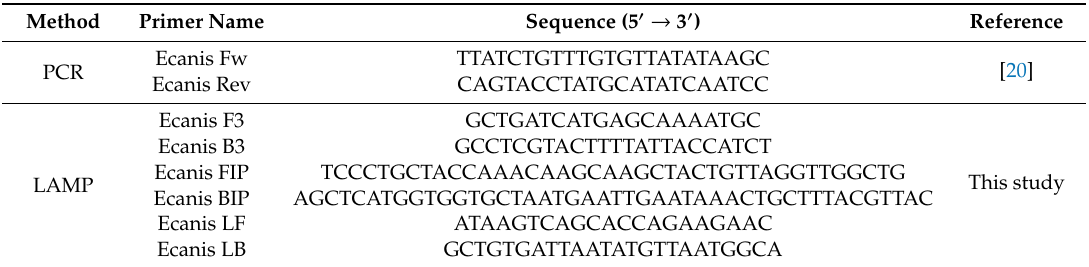
Table 1. List of primers targeting Ehrlichia canis gltA used in PCR and